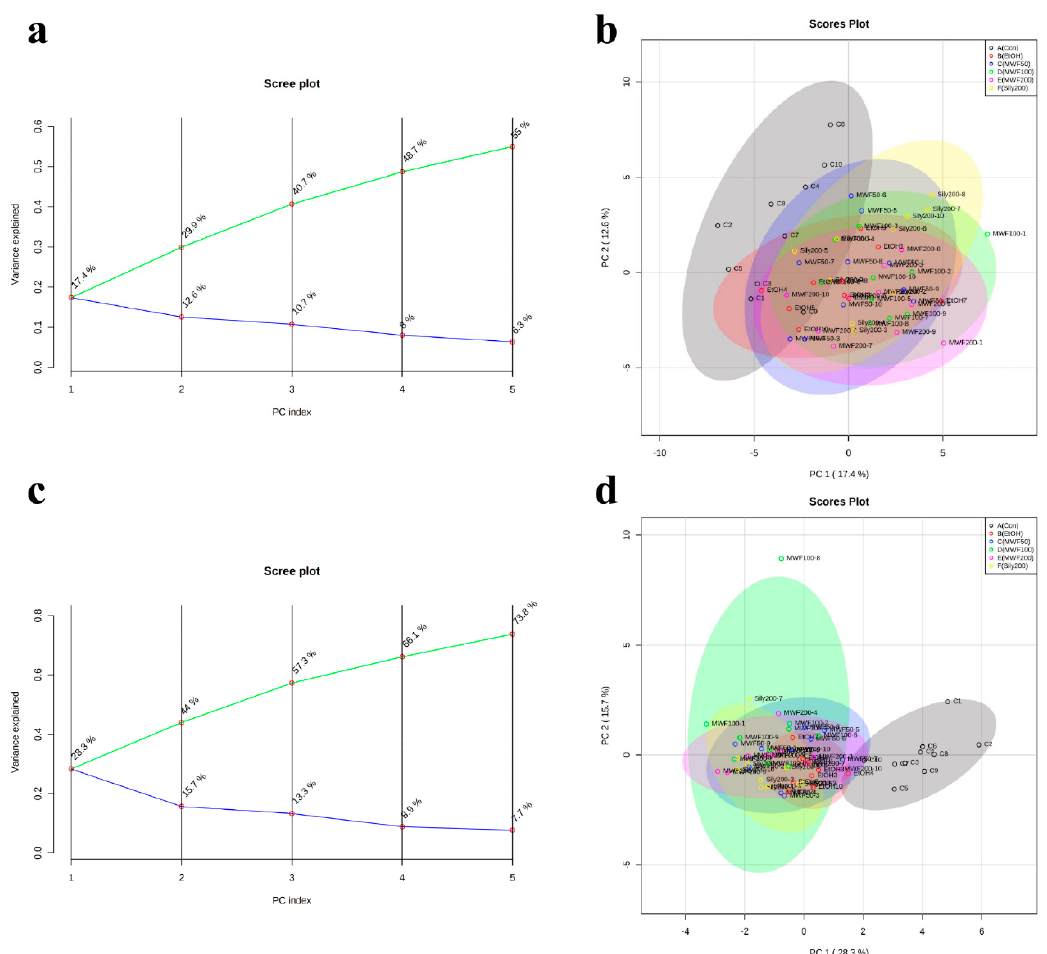
Figure 3. Principal component analysis (PCA) analysis for the Con, EtOH, MWF 50, 100, 200, and Sily200 groups. ( a ) Scree plot, PCA variance explained; ( b ) PCA score plot; ( c ) scree plot, and ( d ) PCA score plot of significant metabolites in ANOVA.